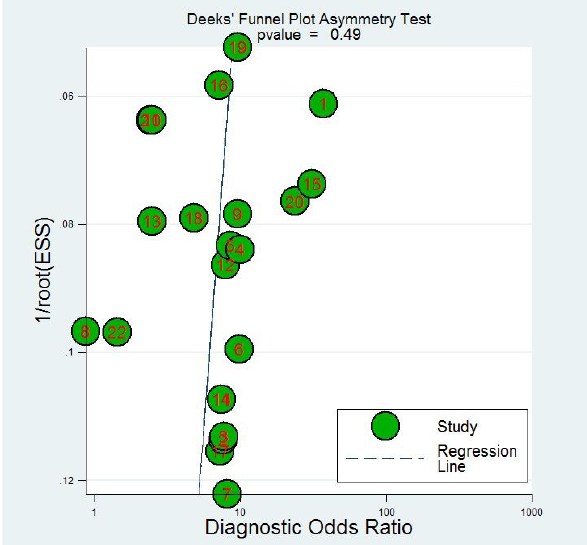
Figure 9: Deeks’funnel plot for evaluation of the publication bias